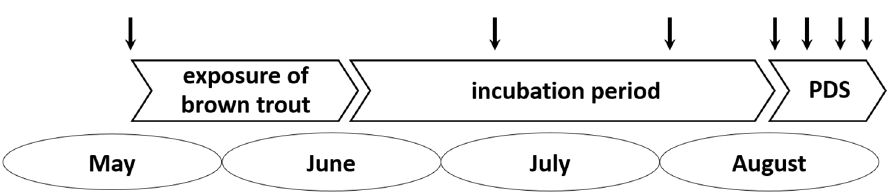
Figure 2. The timeline of the PDS exposure experiment in 2009. Brown trout were exposed to the water of the PDS affected river Iller during May and June. The first signs of PDS appeared in mid-August. The arrows indicate the time points of sampling.